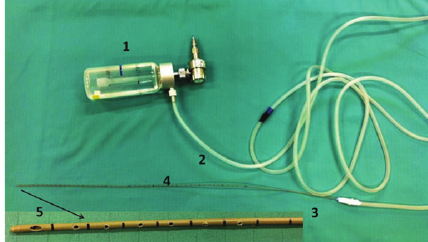
Figure 2: Handmade device developed to provide oxygen sup- plementation during tracheal stent. Placement: a portable oxygen flowmeter (1) is connected with a 1-meter long silicon tube (2). The free end of the silicon tube is joined together with the proximal end (3) of a 16Fr. ureteral catheter (4), whose opposite end is modified withseveralhandmadeorifices(5)startingfromapproximately6 cm from the distal tip.